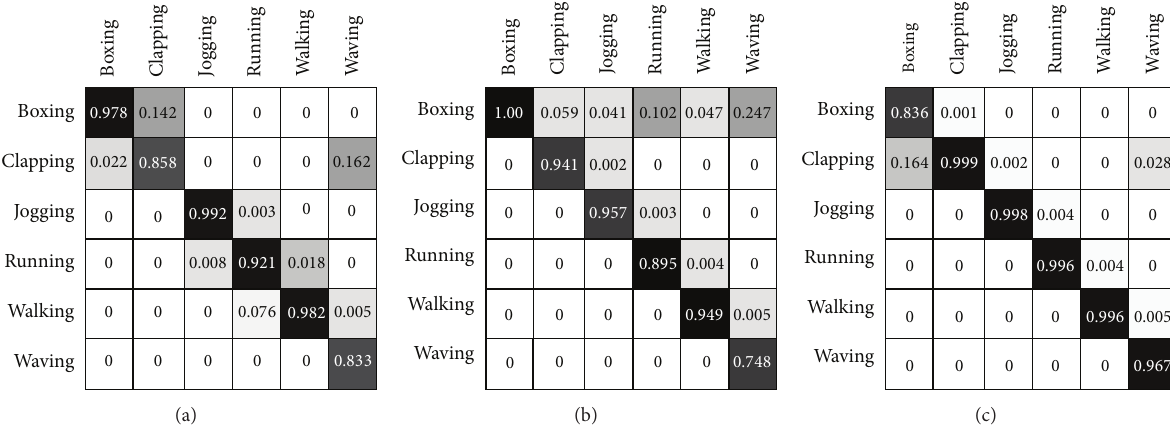
Figure 6: Confusion matrices ELM classifying KTH dataset attained by adapted active basis model as combination of form and motion pathways. Confusion matrices of the proposed approach have been presented which is obtained from human action movements of KTH dataset [39]. There are three different kernels which have been used in classifying using ELM algorithm [33–38] in the decision making and categorization of the biological movement. From left to right, RBF kernel-ELM, wavelet kernel ELM, and sigmoid-ELM confusion matrices have been depicted where sigmoid kernel-ELM has better results in classification of biological movement. The accuracy of categorizations is ELM-Wav = 91.5%, ELM-RBF = 92.7%, and ELM-Sig =